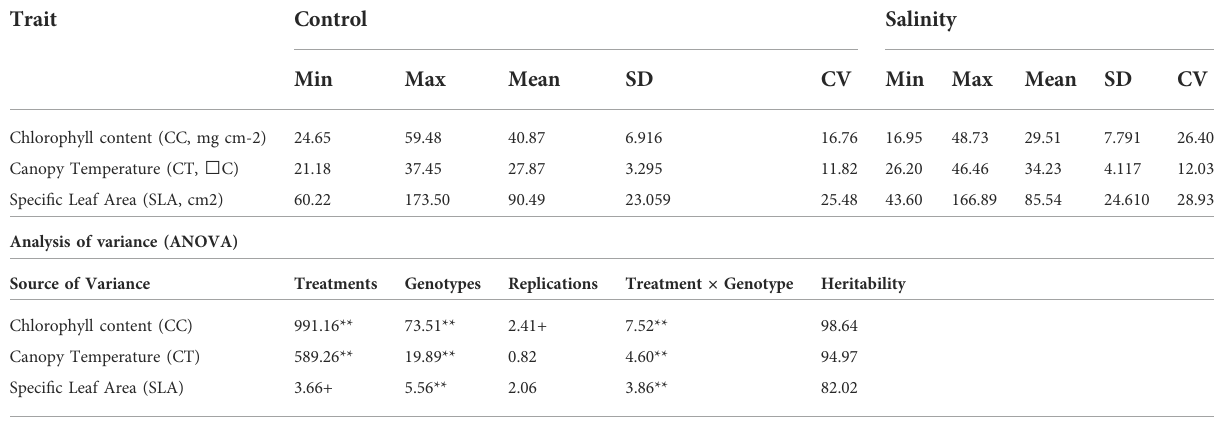
TABLE 1 Ranges, means, standard deviation (SD), coef fi cient of variation (CV) and analysis of variance (ANOVA) for all traits scored on wheat under control and salinity. Min stands for minimum, Max for Maximum and STI for Salt Tolerance Index.